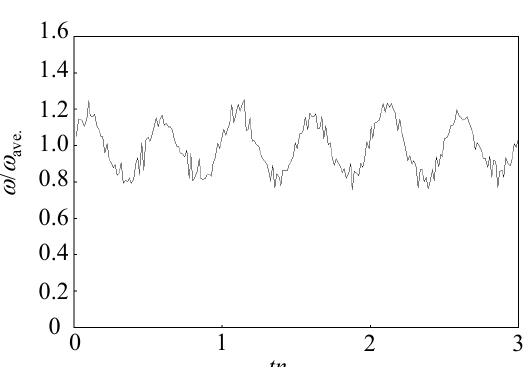
Fig. 21 Dimensionless angular velocity ω / ω ave. of rectangular plate versus reduced time tn for inertia-moment ratio I * = 2.5, Re ( V ) = 3.54 × 10 4 ( Re = 1.4 × 10 3 – 1.6 × 10 3 ), at depth-to-width ratio λ = 0.3, aspect ratio AR = 10.